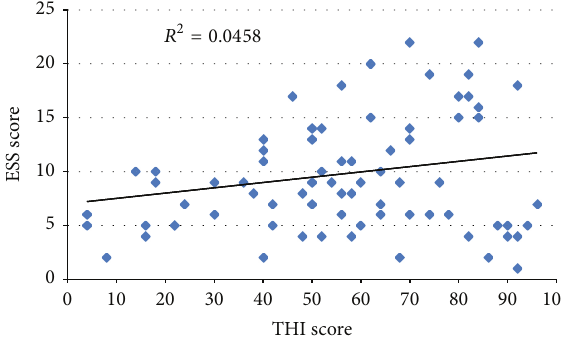
Figure 2: Scatterplot of Tinnitus Handicap Inventory (THI) score versus Epworth Sleepiness Scale (ESS) score.